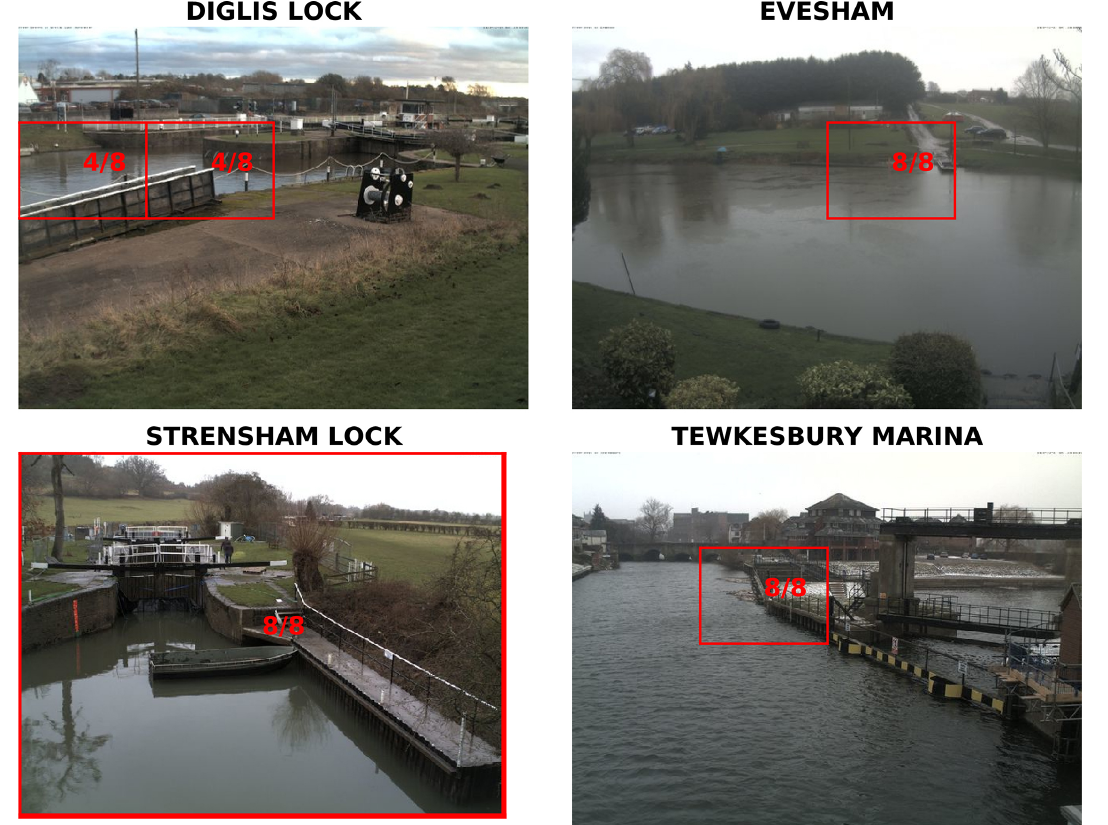
Figure 11. Windows of the 4 × 4 grid where the segmentation gives the best correlation with the water level for at least one of the eight networks considered. The fractions correspond to the proportion of networks that selected the corresponding window as the one giving the best